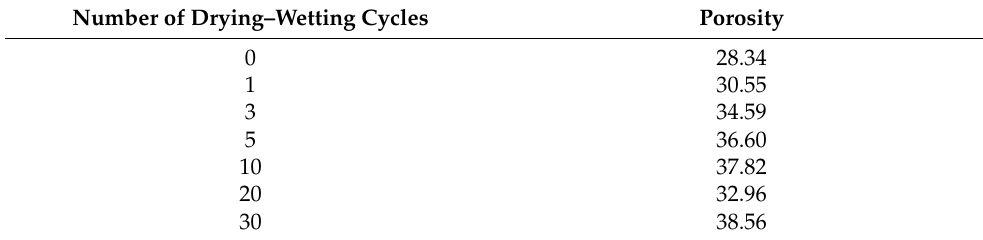
Table 7. Porosities of Yili loess samples after different numbers of drying–wetting cycles. Number of Drying–Wetting Cycles